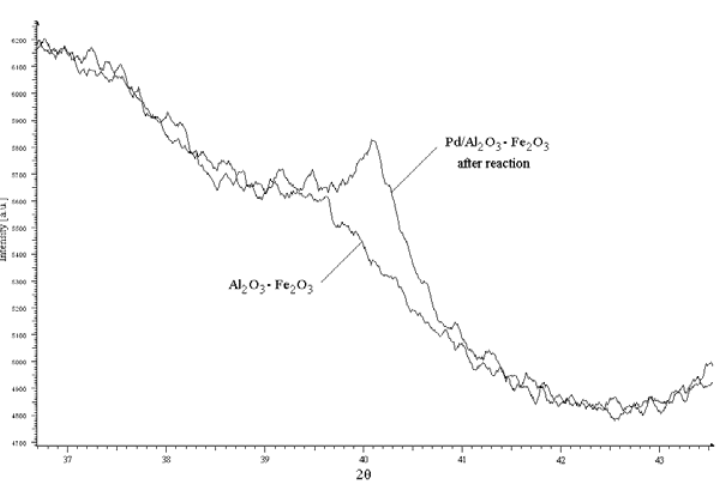
Figure 6. TEM of the Pd/Al